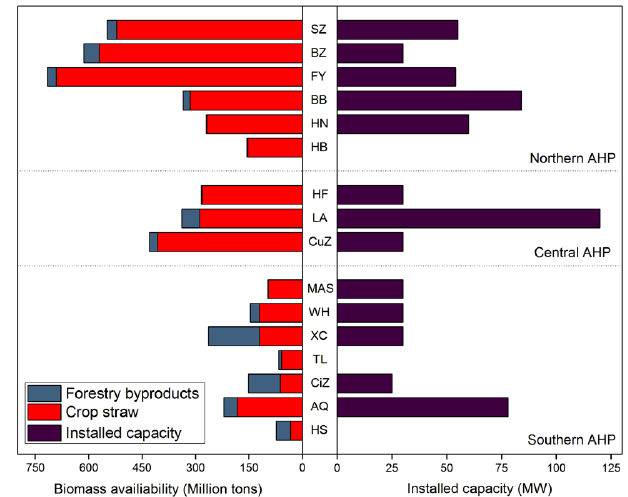
Figure 4. The biomass availability and installed capacity of biomass power plant in AHP,